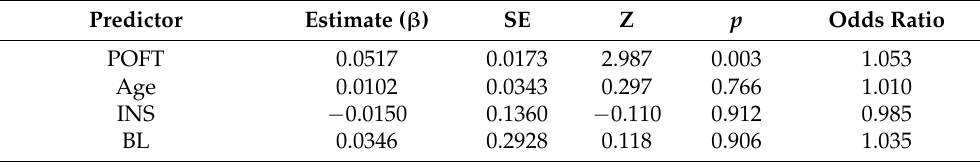
Table 4. Model 1 coefficients.